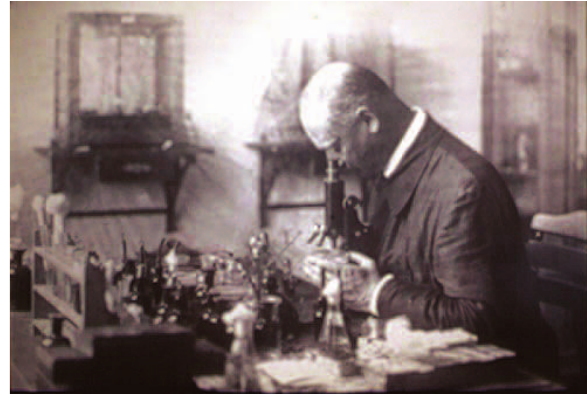
Fig. 5. Lionello Petri (1875-1946) in his laboratory at Florence, Italy.